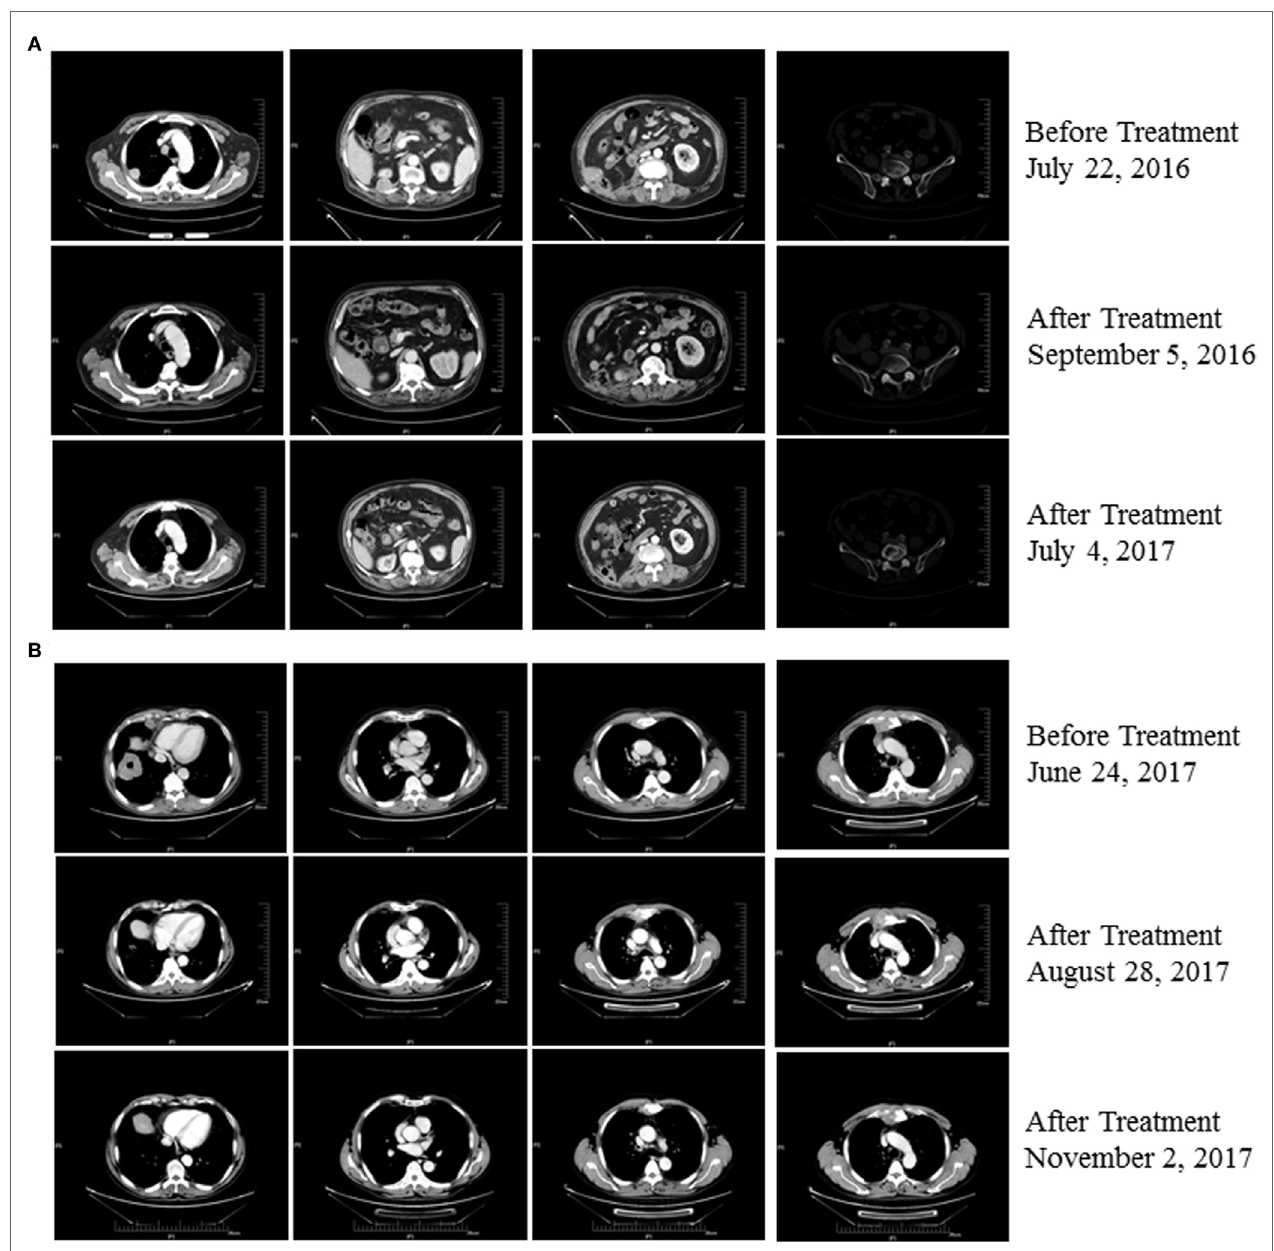
FIgURe 1 | (a) Patient 1 exhibited a complete response after three cycles of treatment with pembrolizumab plus cytokine-induced killer (CIK) cell transfer and continues to be in remission 537 days posttreatment (as of 12/02/2017). (B) Patient 2 exhibited a partial response after two cycles of treatment with pembrolizumab plus CIK cell transfer and continues to be in remission on day 185 after treatment (as of